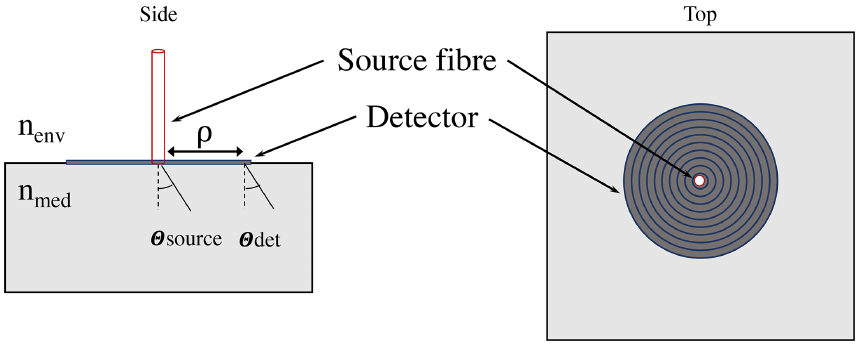
Figure 3. Schematic of the numerical environment used to simulate R sim (ρab (cid:48) γ) with the Monte Carlo method.